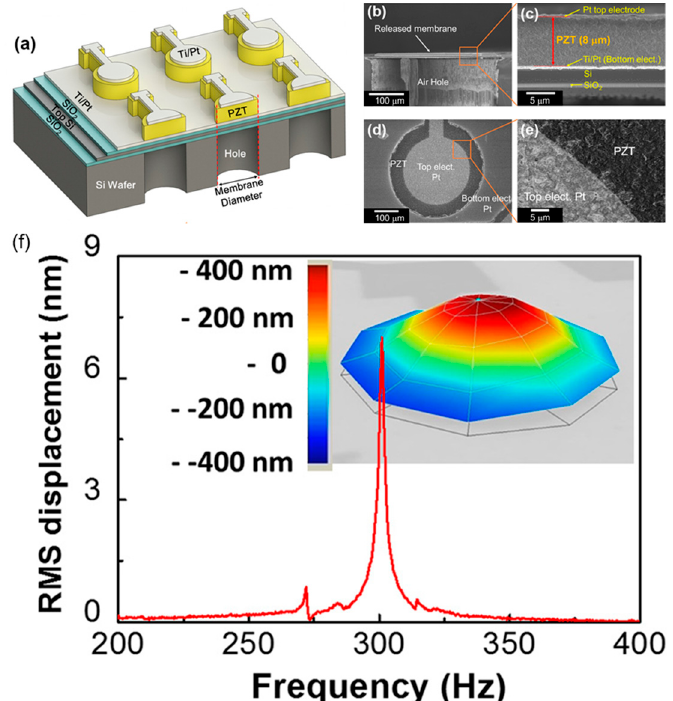
Figure 28. ( a ) Schematic of the PZT-Piezoelectric micro-machined ultrasonic transducer (pMUT) device. SEM images of ( b , c ) cross-sectional view of the pMUT membrane; and ( d , e ) top view of the pMUT element. ( f ) RMS displacement as a function of the frequency of a pMUT element [68]. © Copyright 2017, Appl. Phys. Lett.